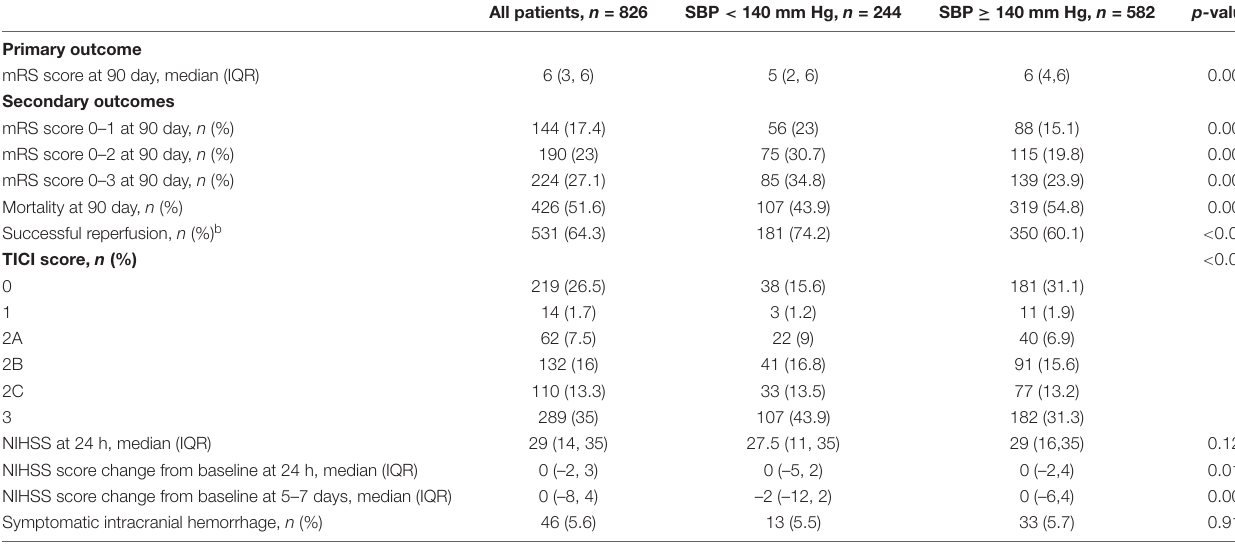
TABLE 2 | Outcomes according to admission systolic blood pressure.